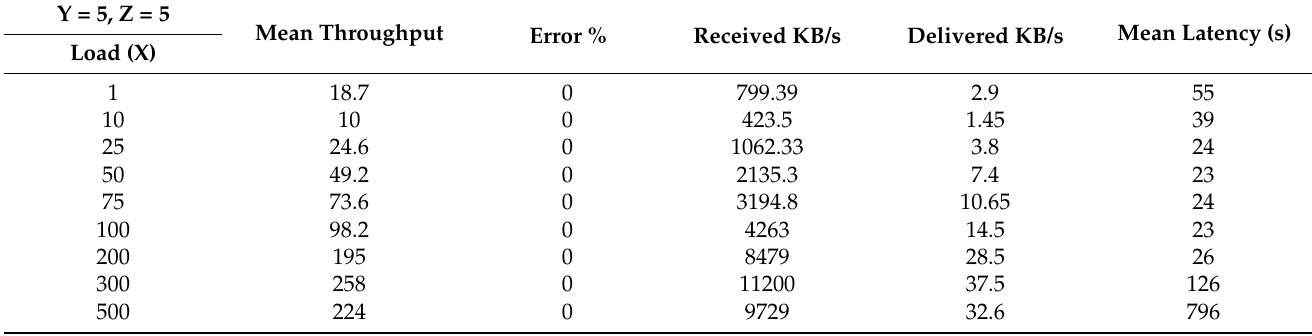
Table 12. Scalability testing results with Y = 5, Z = 5, and variable loads